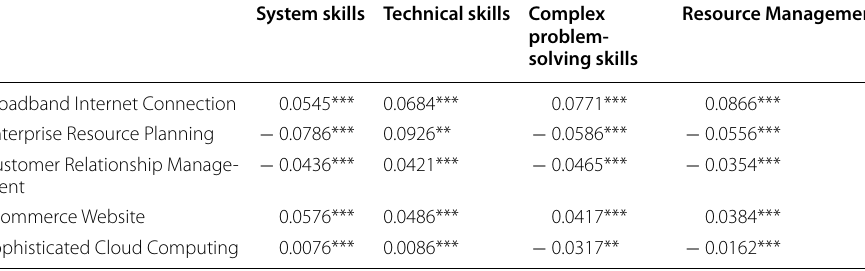
***, ** and * correspond to p < 0.01, p < 0.05 and p < 0.1